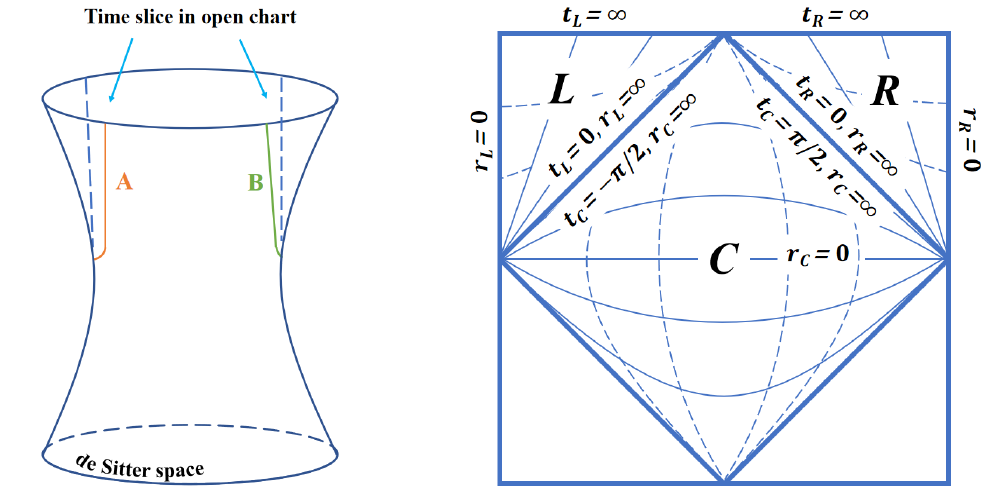
Figure 1 . De Sitter space and its Penrose diagram. The R and L regions are the causally discon- nected open charts of de Sitter